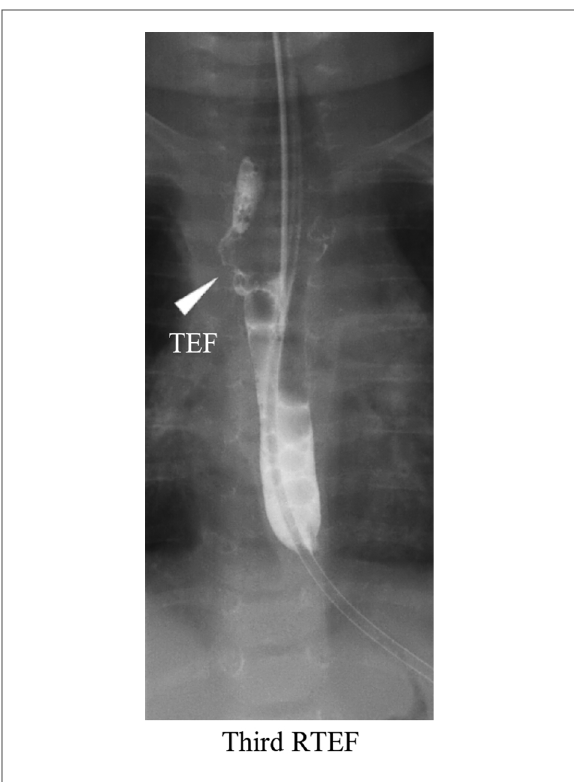
FIGURE 4 A contrast examination of the esophagus shows the third RTEF at the exact location of the fi rst and second RTEFs (arrowhead). RTEF, recurrent tracheoesophageal fi stula.